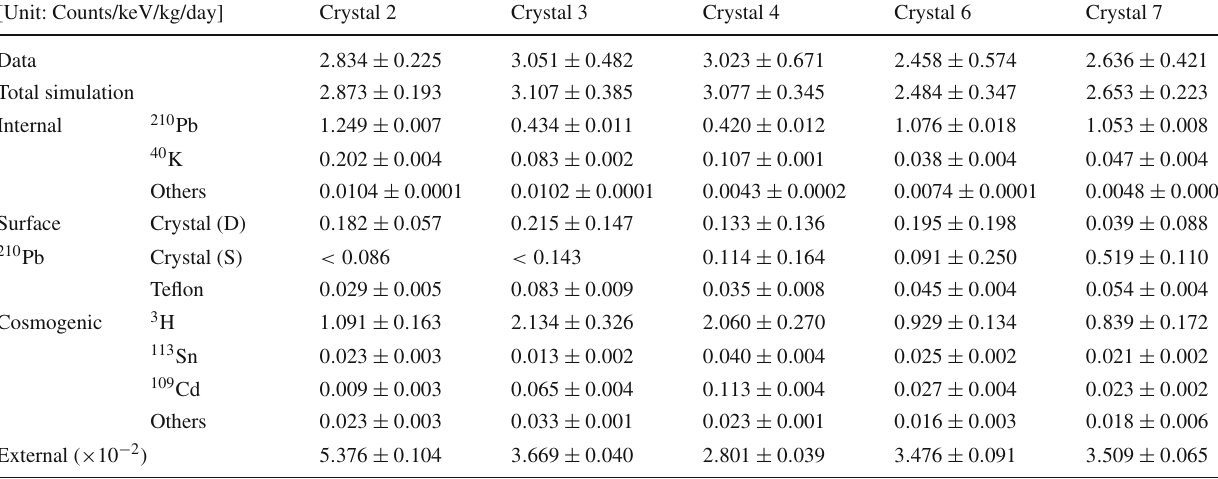
Fig. 7 The energy spectra of single-hit (top) and multiple-hit (bottom) events in Crystal 7. The MC was carried out to fit the measured data. The shaded area in the energy spectra of single-hit events is excluded from the data fitting Table 2 Background contributions in the energy range of 1–6 keV. D and S denote deep and shallow depth, respectively. Corrections for There are only statistical uncertainties for the data row, and uncertain- event selection efficiency are applied to the measured data ties for other rows are from the modeling. In the rows for surface 210 Pb,